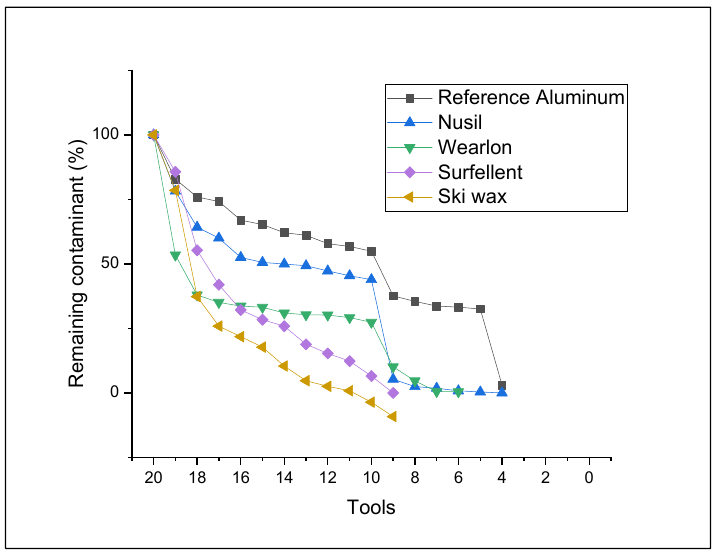
Figure 12. Multi-tool analysis under partially melted and refrozen snow–simulation of dry snow on a warm soaked surface. Note: Numbers correspond to the tool used and number of passages during de-icing. Where “20 to 16” represent the broom, “15 to 11” represent the soft polymer blade, “10 to 6” represent the squeegee, and “5 to 1” represent the hard polymer blade.